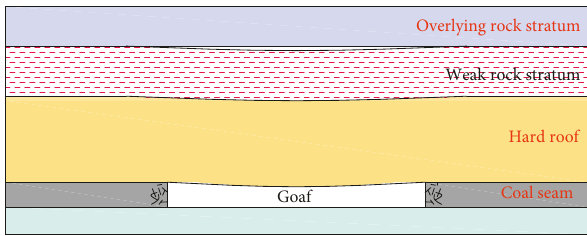
Figure 3: State of the hard roof before the initial breakage event.